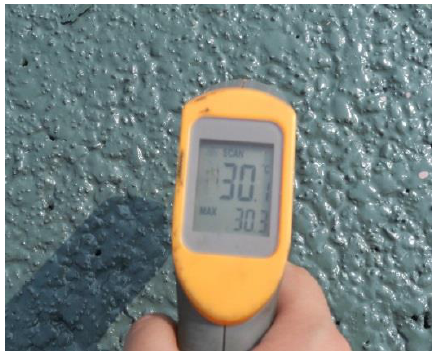
Figure 4. Temperature measurement for the coating.